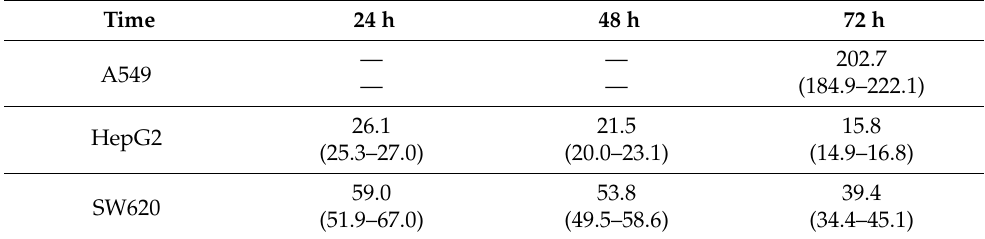
Figure 1. Viability of A549, HepG2 and SW620 as a function of the AgNP concentration; arithmetic mean ± SEM; n = 3, neutral red test. Incubation time: 24, 48 and 72 h. Table 1. The summary of Ag20 cytotoxicity in A549, HepG2 and SW620 cell lines. The results are presented as the IC 50 mean value ( µ g/cm 3 ) ± the 95% confidence interval, n = 3. “—” was not determined for the IC 50